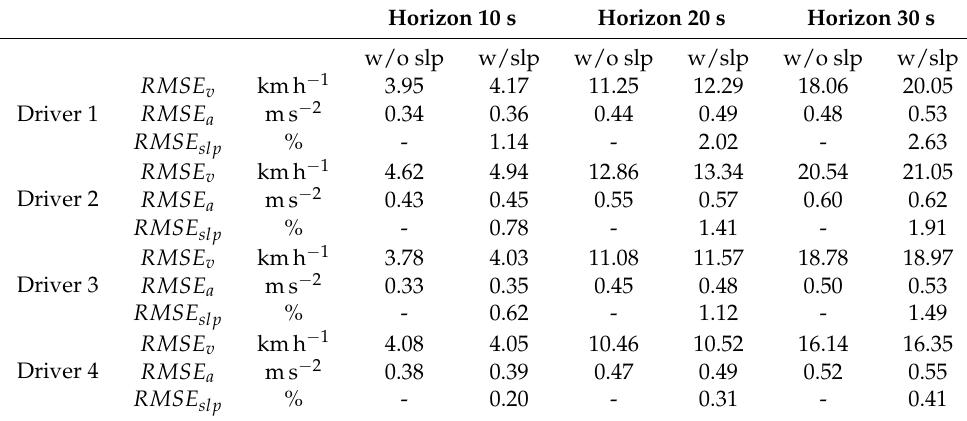
Table 5. RMSE using MC for different prediction horizons.